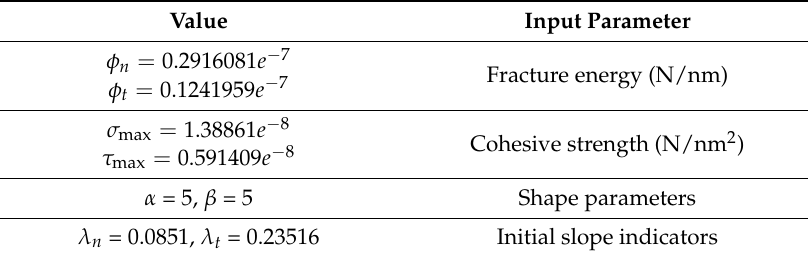
Table 1. The values of input parameters to the Park, Paulino, and Roesler (PPR) model.